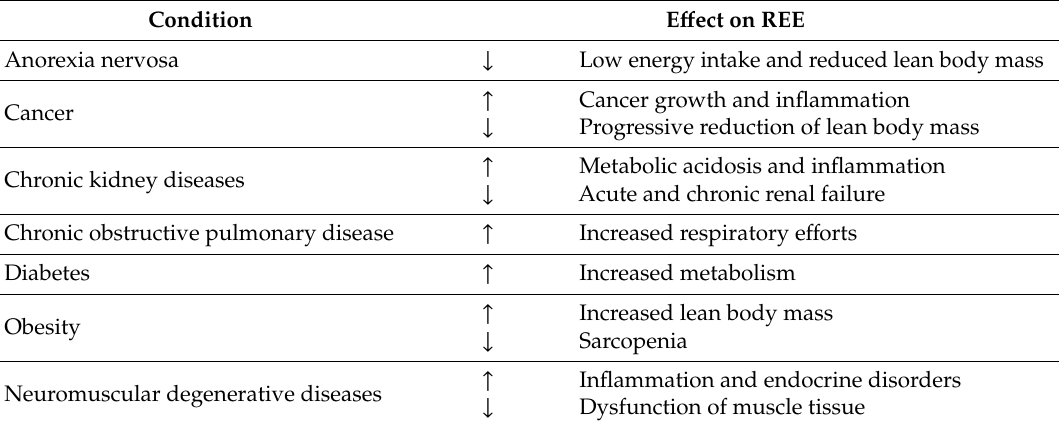
Table 2. Common chronic pathologies with e ff ects on resting energy